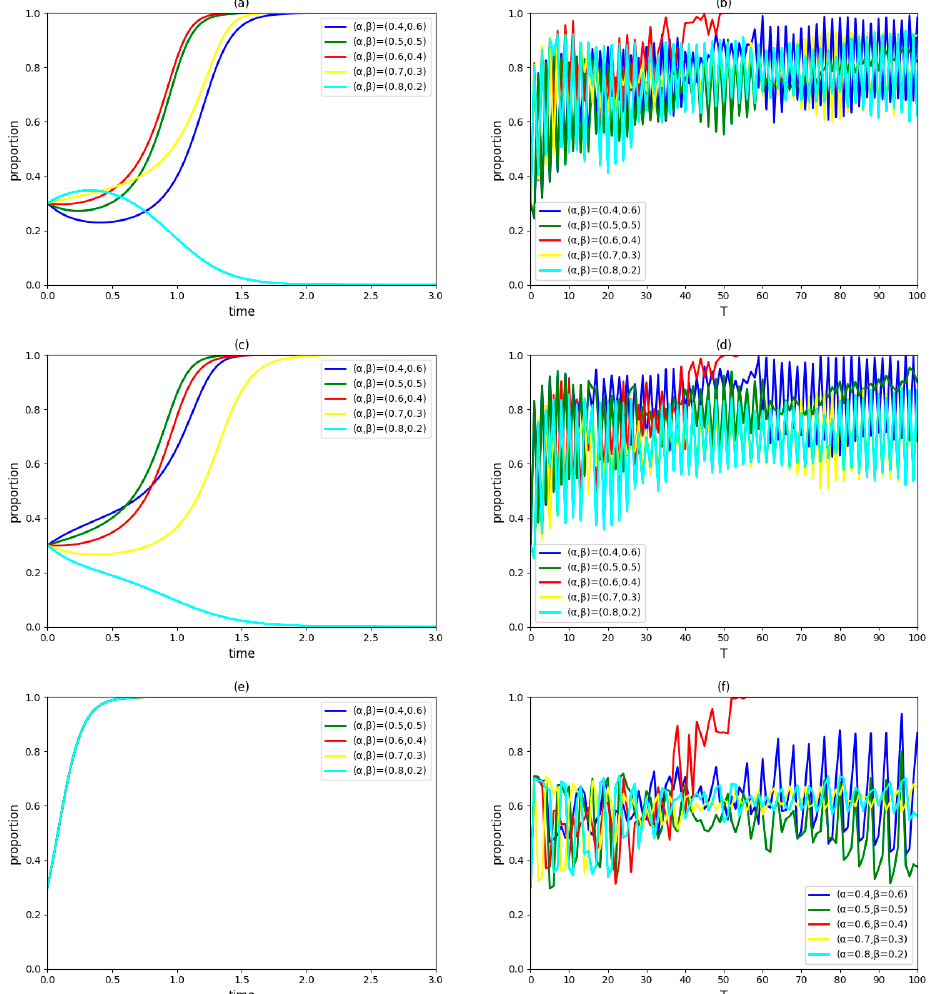
Figure 2. ( a ) The evolutionary paths of enterprise strategies with different proportions of cooperative innovation revenue distribution. ( b ) The proportion of cooperative enterprises in the region over time. ( c ) The evolutionary paths of university/institute strategies with different proportions of cooperative innovation revenue distribution. ( d ) The proportion of cooperative universities/institutes in the region over time. ( e ) The evolutionary paths of government strategies with different proportions of cooperative innovation revenue distribution. ( f ) The implementation of the proportion of the government adopting a participation strategy in the region over time .